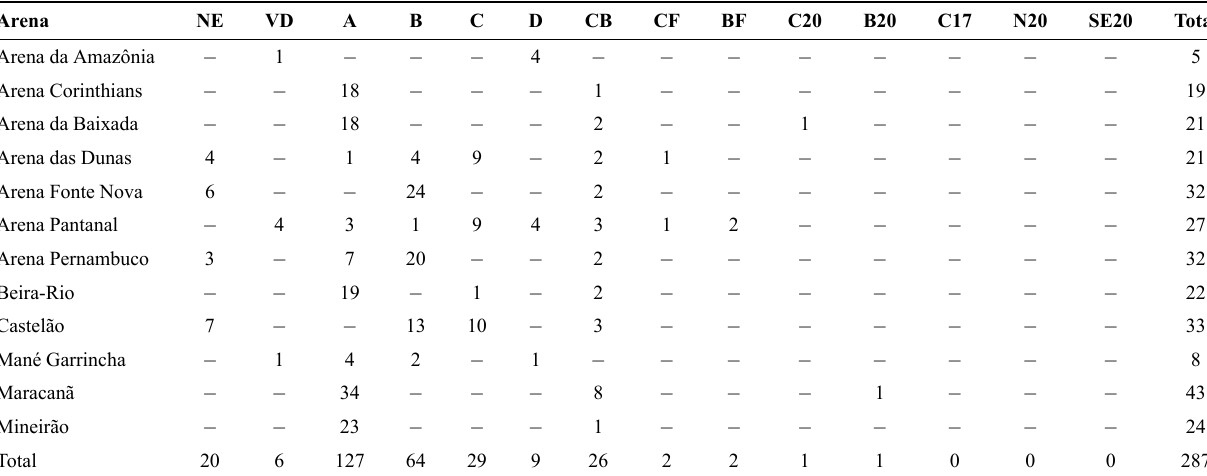
Table 3 - Arena Usage in the 2015 season.